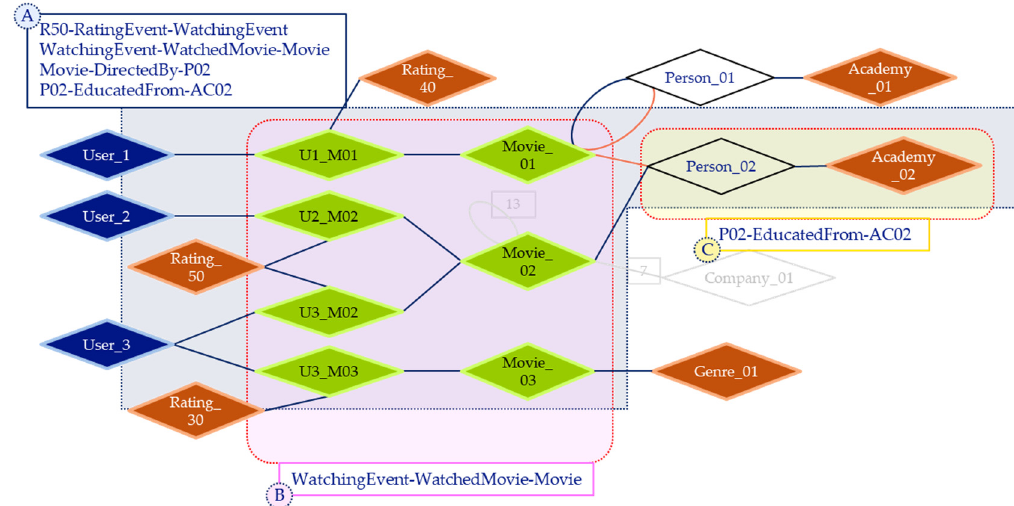
Figure 16. Final frequent subgraphs.